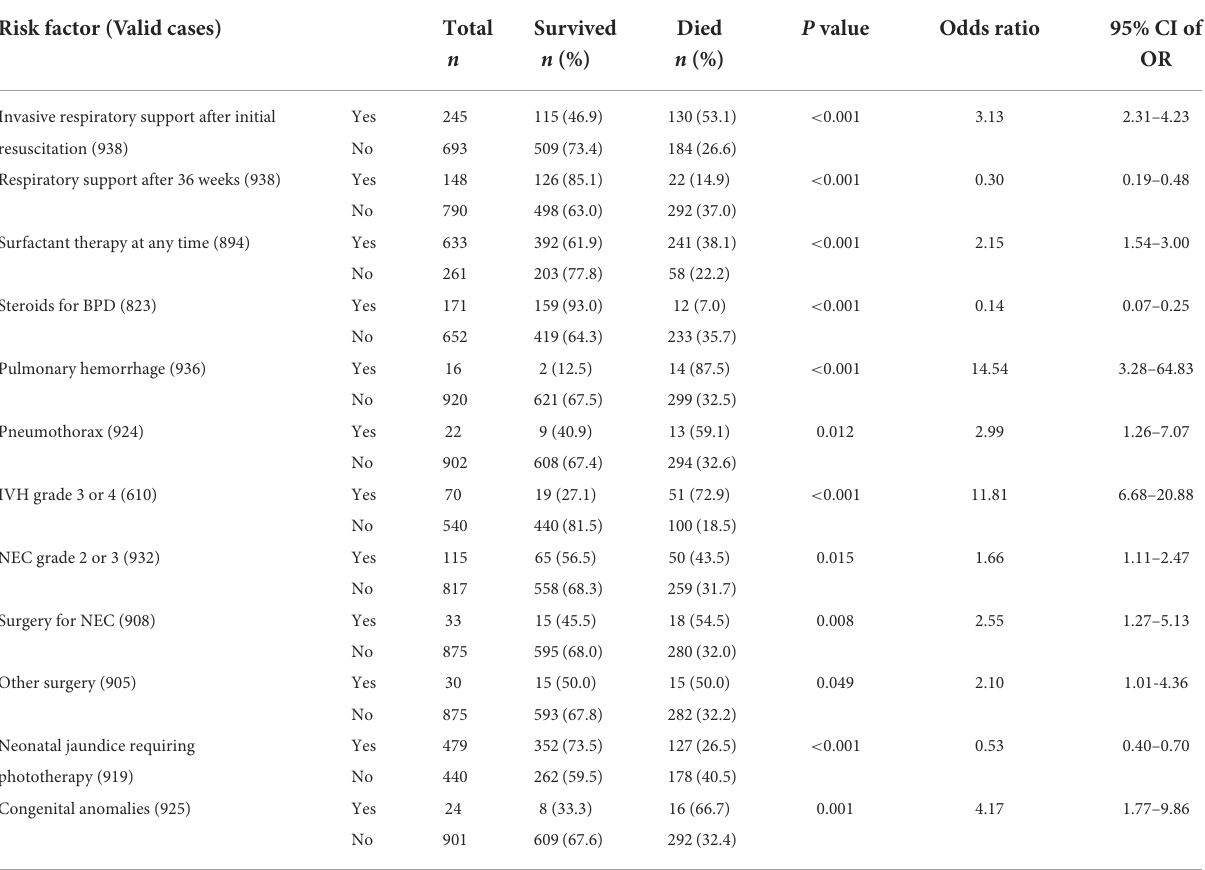
TABLE 3 Risk factors for mortality related to disease and treatment among studied infants.